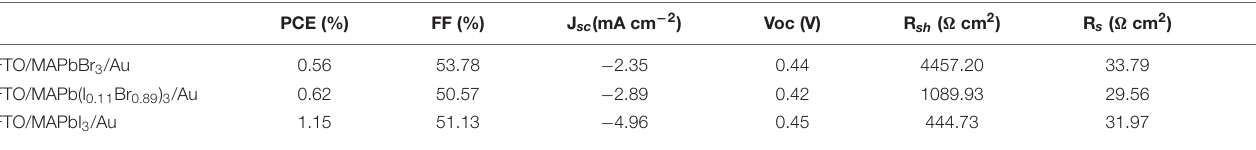
FIGURE 7 | Current density—voltage characteristic for FTO/MAPbI 3 /Au, FTO/MAPbBr 3 /Au and FTO/ MAPb(I 0 . 11 Br 0 . 89 ) 3 /Au solar cells under illumination. TABLE 1 | The power conversion efficiency (PCE), fill factor (FF), short circuit current density (J sc ), open circuit voltage (V oc ), short resistance (R sh ) and series resistance (R s ) of FTO/MAPbBr 3 /Au, FTO/MAPb(I 0 . 11 Br 0 . 89 ) 3 and FTO/MAPbI 3 /Au solar cells under